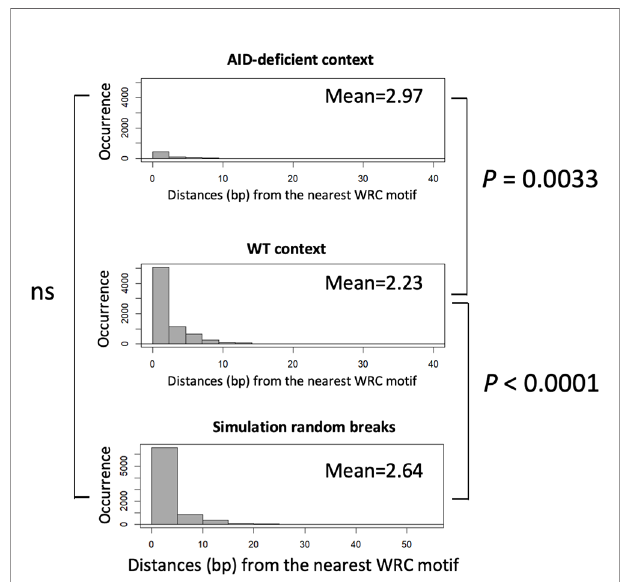
FIGURE 4 | Comparison of distances between CSR breaks and nearest activation-induced deaminase (AID) target sites. Distances between the position of DNA breaks and nearby WRCY sites were scored in either junctions from wild type B-cells, AID-de fi cient B-cells, or a control reference distribution of random breaks (4,000 junctions). An approximate permutation distribution test built from 100,000 random permutations was performed. ns, non signi fi